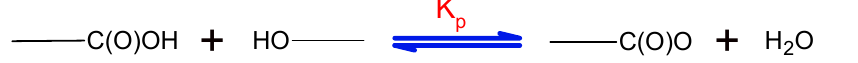
Figure 2. Examples of stepwise polycondensation reactions for the preparation of polyesters [10].